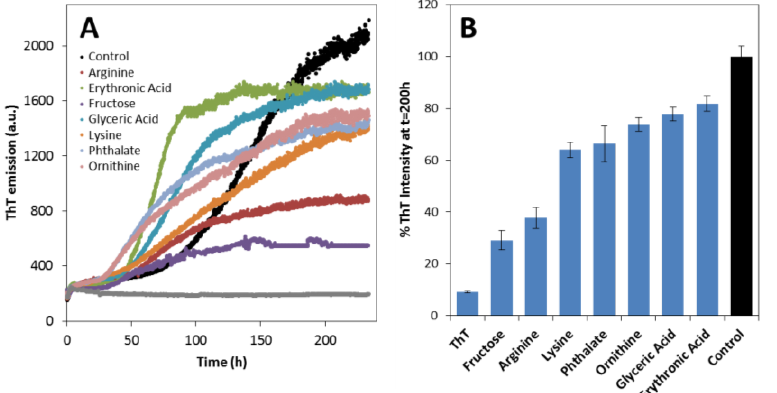
Figure 3. Metabolites promote aggregation of apoSOD1. ( A ) Aggregation kinetics of 50 μM apoSOD1 monitored by ThT fluorescence emission, in the absence (black) and in presence (colors) of 200 μM metabolites; ( B ) Plot of ThT fluorescence intensity at 200 h (from traces in panel A ). Both panels are representative of 3 independent measurements with 50 μM apoSOD1 at pH 7.4 under agitation at 37 °C with and without 200 μM of each metabolite. The ThT bar represents the fluorescence intensity of the probe in the absence of protein and metabolites. See experimental section for further details.